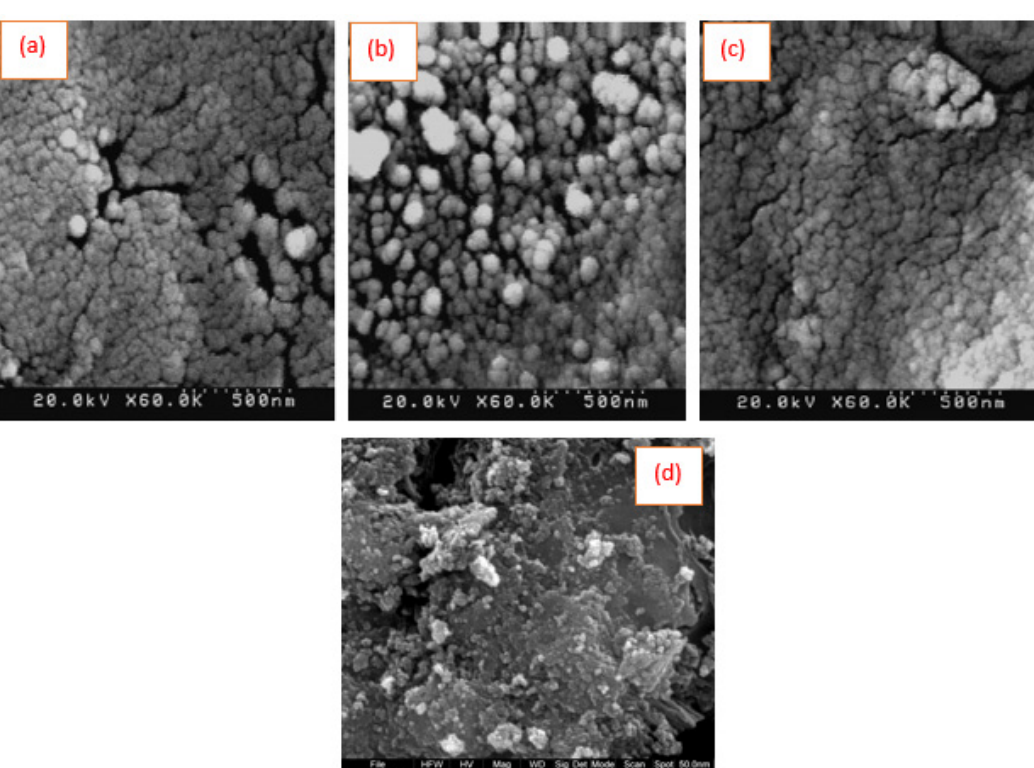
O and Alg-mHap 3 4